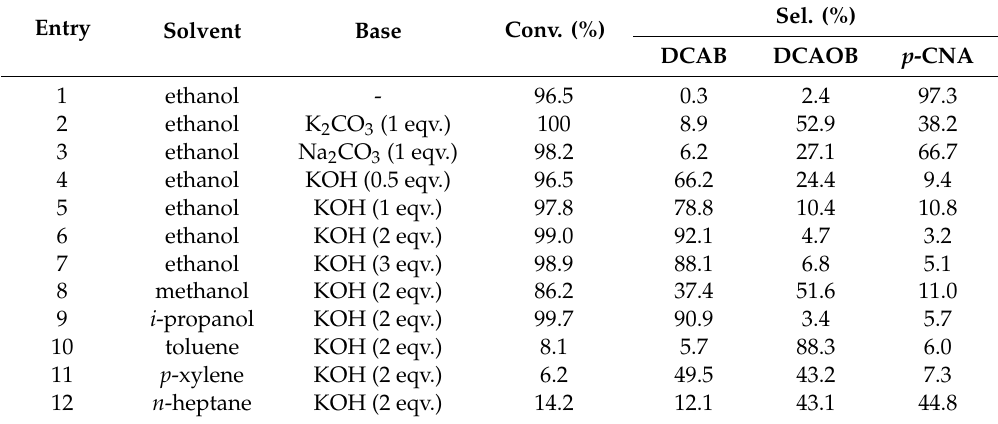
Table 2. E ff ect of solvent and base on the coupling reactions of p